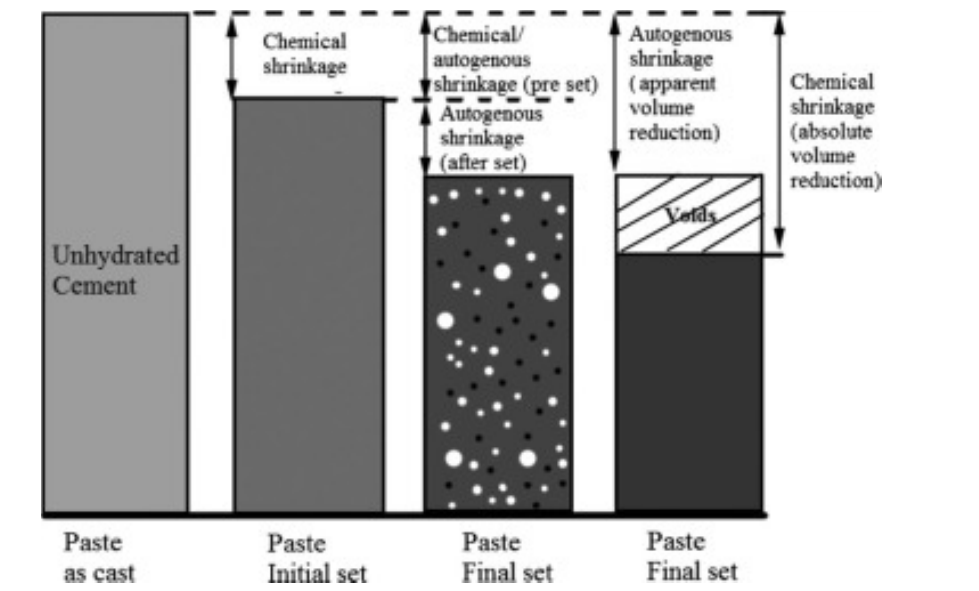
Figure 2. Illustration of concrete shrinkage [1].